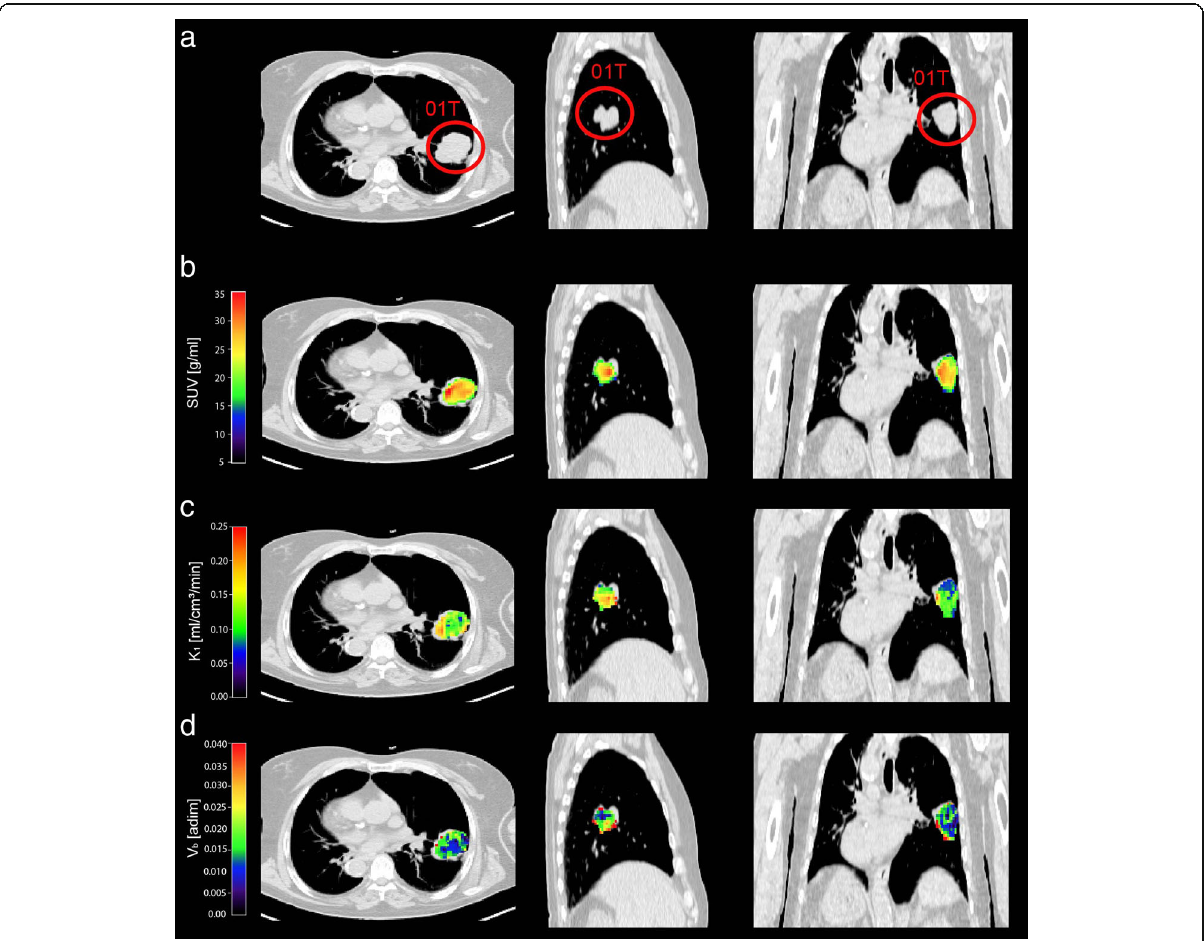
Fig. 4 Parametric maps of SUV, K 1 and V b in a representative patient. Transaxial, lateral and frontal views of thoracic CT image: the primary lung cancer is highlighted by red circle ( a ). Map of SUV ( b ) within primary lung cancer over-imposed on thoracic CT image ( b ). Voxel-wise parametric maps of K 1 and V b obtained with 3K model in primary lung cancer over-imposed on thoracic CT image ( c and d ). CT , computed tomography; SUV , standardized uptake value; K 18 F-FDG transport rate from plasma to tissue; V 1 , b , blood volume